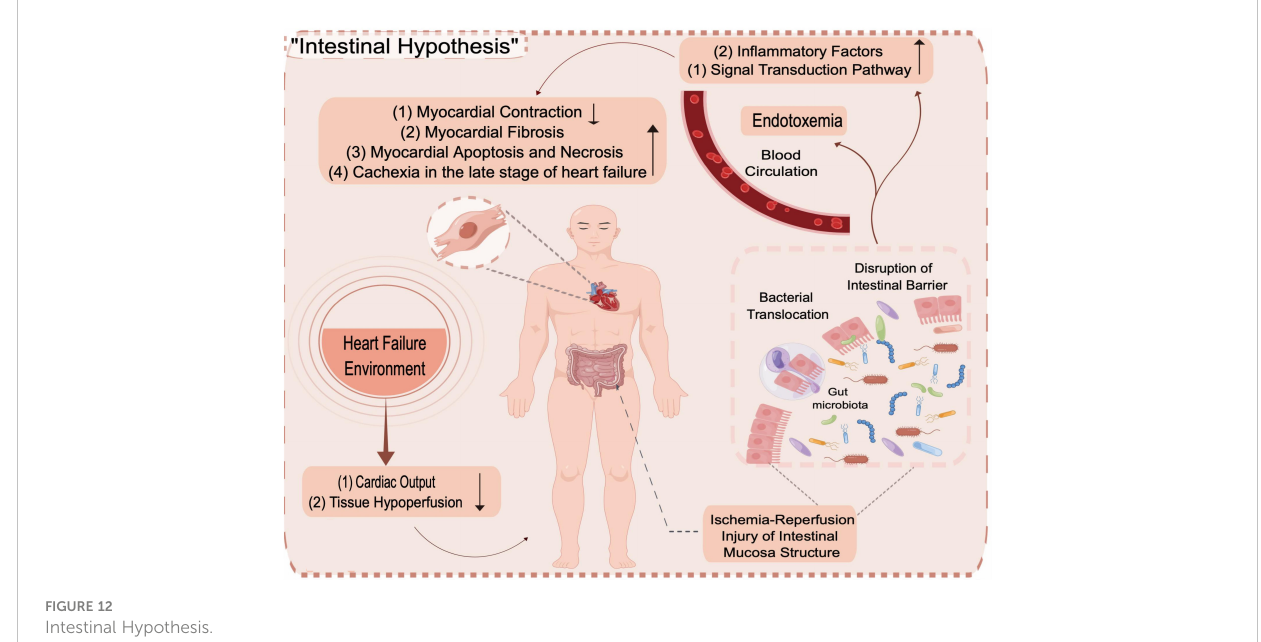
FIGURE 12 Intestinal